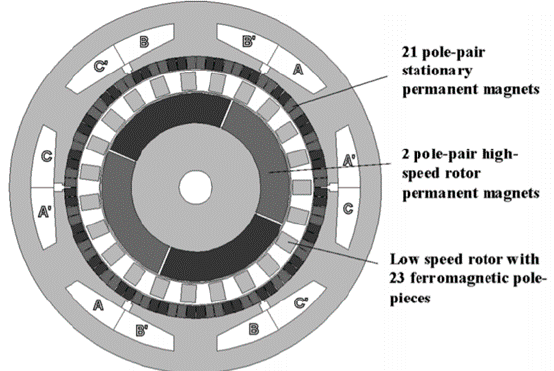
Figure 3. Configuration of a pseudo direct drive PM (PDD-PM) machine [15].